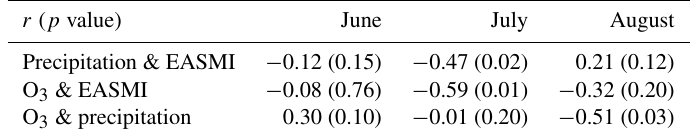
Table 4. Correlation between the surface ozone (1994–2013), NCEP reanalysis precipitation (1990–2015), and EASMI (1990–2015).